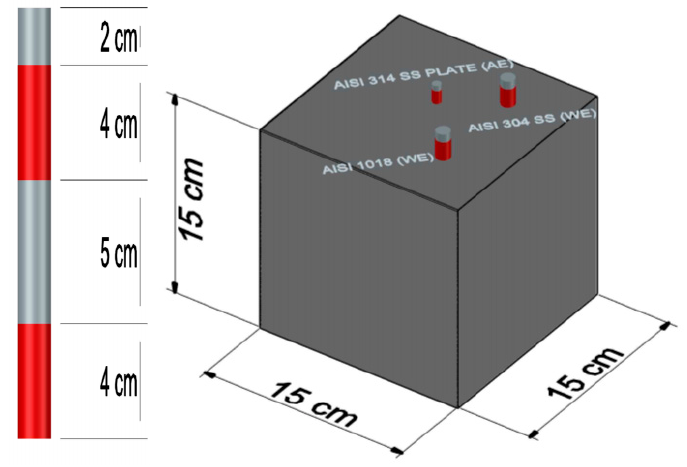
Figure 1. Experimental design of the rebars and concrete specimens.